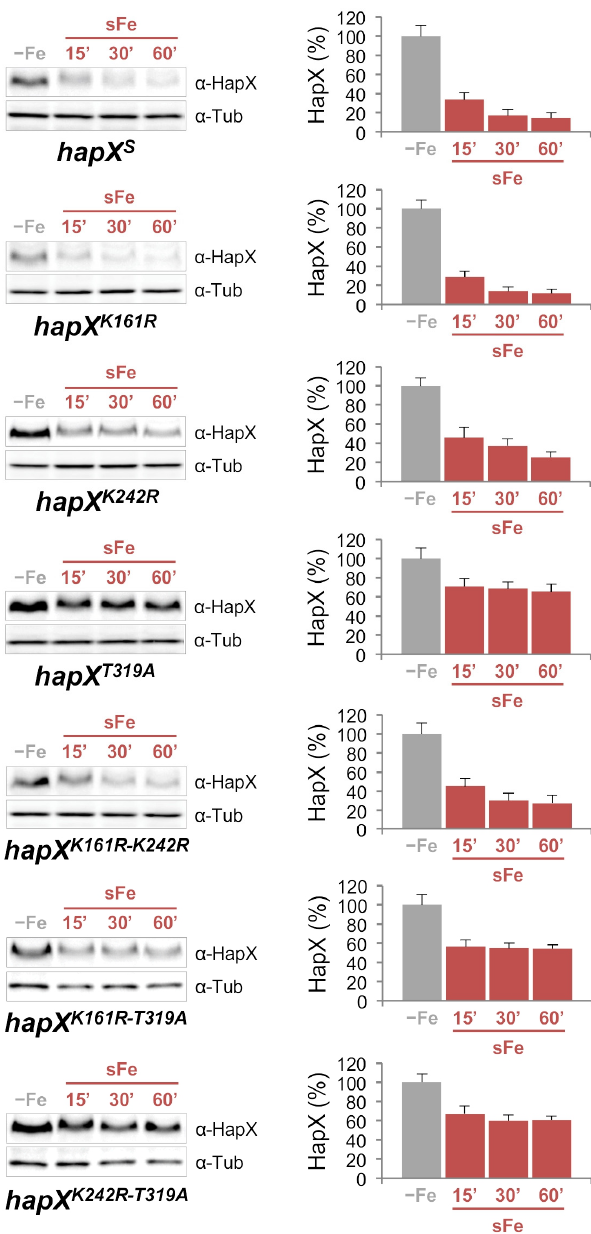
HapX quantification by Western blot analysis. Samples were obtained from the indicated strains grown under sFe conditions as in Figure 2B. Left panels: Representative Western blot analysis showing HapX protein levels. α -Tubulin was used as loading control. Right panels: Densitometric protein quantification. HapX protein levels were normalized to Tubulin and expressed relative to those in − Fe. Bars represent standard deviations from two independent biological experiments with two technical replicates